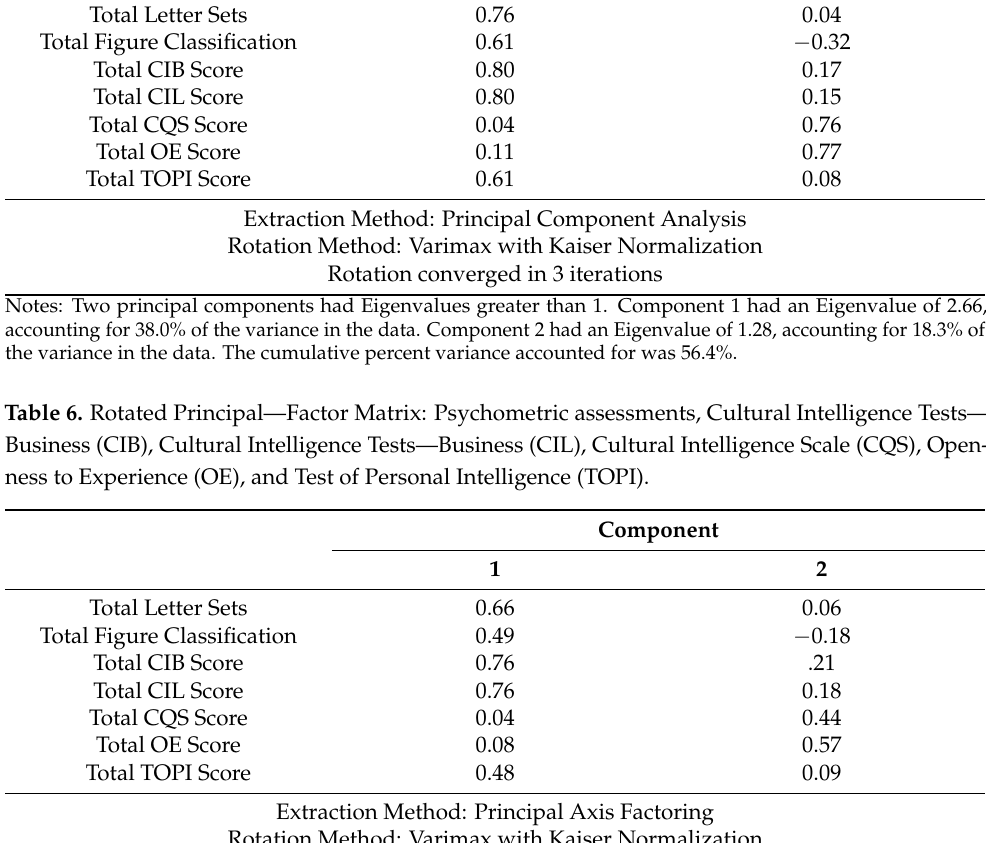
Table 5. Rotated Principal-Components Matrix: Psychometric assessments, Cultural Intelligence Tests—Business (CIB), Cultural Intelligence Tests—Business (CIL), Cultural Intelligence Scale (CQS), Openness to Experience (OE), and Test of Personal Intelligence (TOPI).